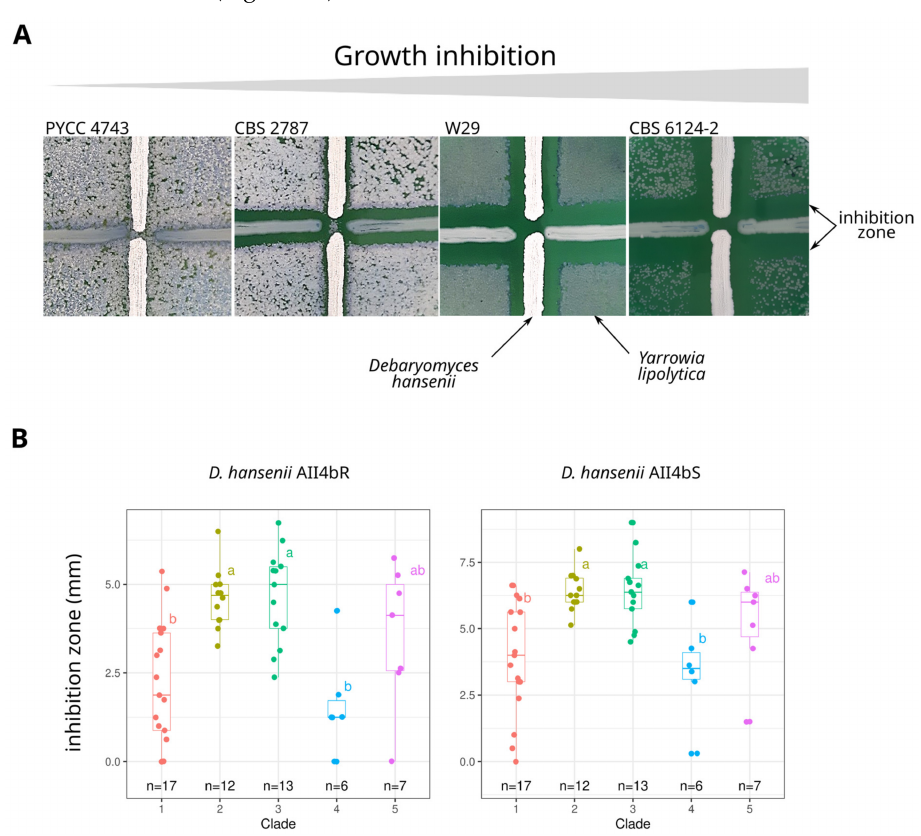
Figure 4. Analysis of the sensitivity to Debaryomyces hansenii killer toxin. ( A ) picture of the inhibition zone around D. hansenii cells expressing the two killer toxins (AII4bR vertical line, AII4bS horizontal line), ( B ) boxplot of the size of the inhibition zone according to the clades, each with a different colour. Letters mark significant differences between clades according to Tukey’s HSD (Honest Significant Difference)